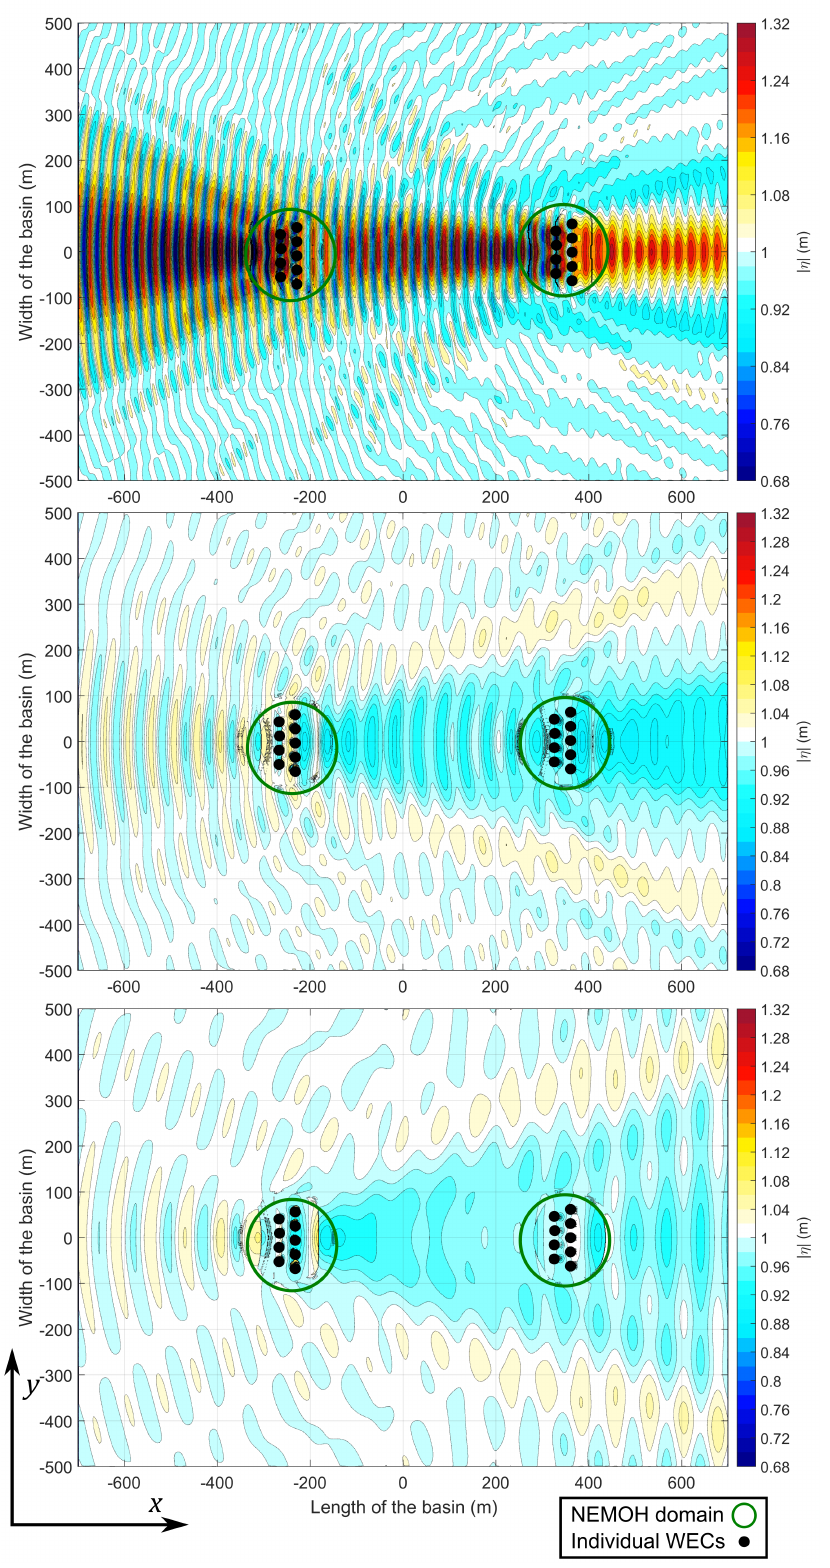
Figure 5. Wave field around two WEC arrays, I (left) and II (right), of nine heaving buoys for regular waves of H = 2 m and T = 6 s (top row), T = 8 s (centre row), and T = 10 s (bottom row). Interarray separation distance D 1 = 600 m or 6 r c . Wave incidence angle β = 0 ◦